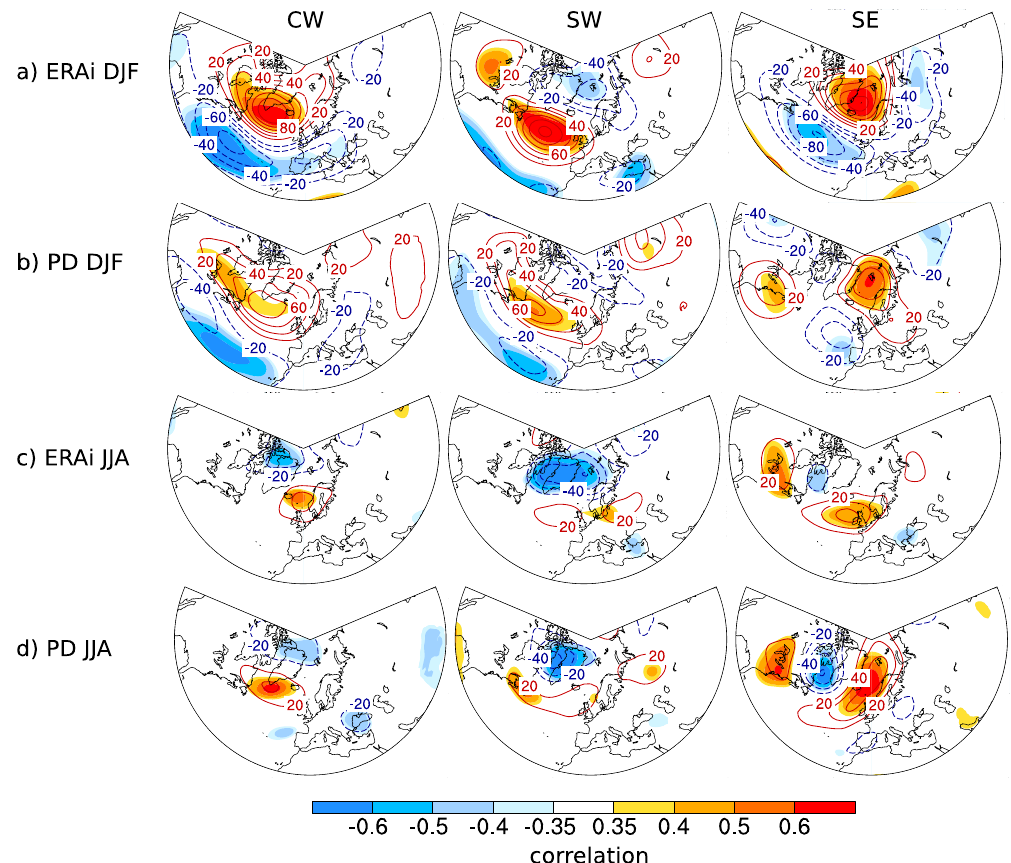
Fig. 8. z500 correlation and plus–minus composite patterns associated with seasonal mean accumulation in CW, SW, and SE for (a) ERAi winters (DJF), (b) PD winters, (c) ERAi summers (JJA), and (d) PD summers. As in Fig. 7, shading illustrates the correlation pattern significant at the 5% level ( t -test statistics) and contour lines illustrate the z500 plus–minus composite (in geopotential height meters). The plus–minus composite corresponds to the difference pattern of the ± 1 standard deviation samples of seasonal mean